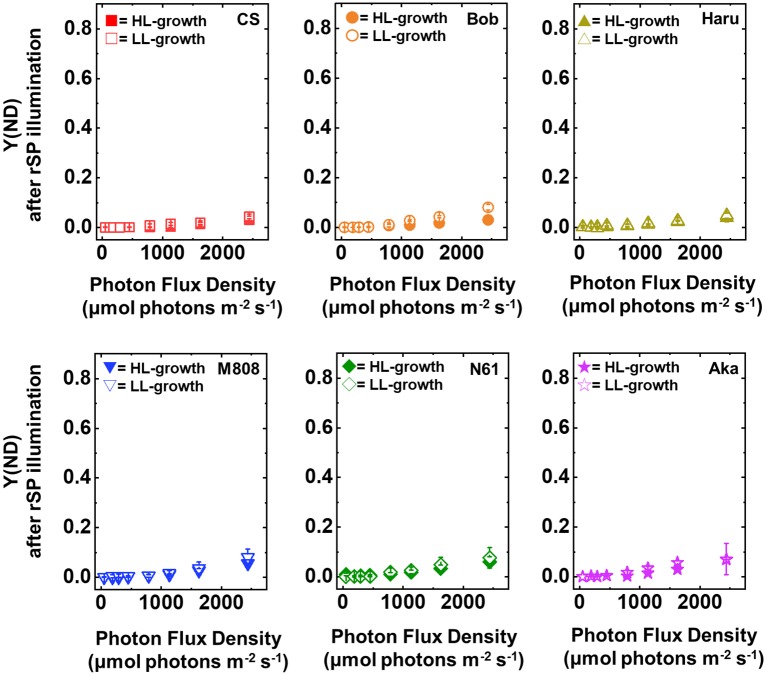
The response of Y(ND) to light intensity in six wheat cultivars grown under LL (open symbol) and HL (closed symbol) conditions after rSP illumination for 1 h. The measurement was conducted under atmospheric conditions (21 kPa O2, 40 Pa CO2) at 25°C. Data are expressed as mean ± SD of three to four independent experiments. Red squares indicate the results of CS, orange circles indicate the results of Bob, dark yellow triangles indicate the results of Haru, blue inverted-triangles indicate the results of M808, green diamonds indicate the results of N61, and purple stars indicate the results of Aka.